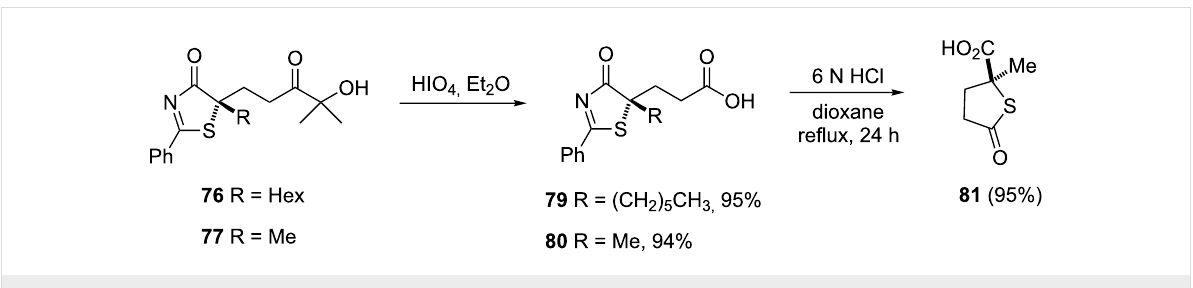
Scheme 14: Elaboration of the thiazolone Michael adducts